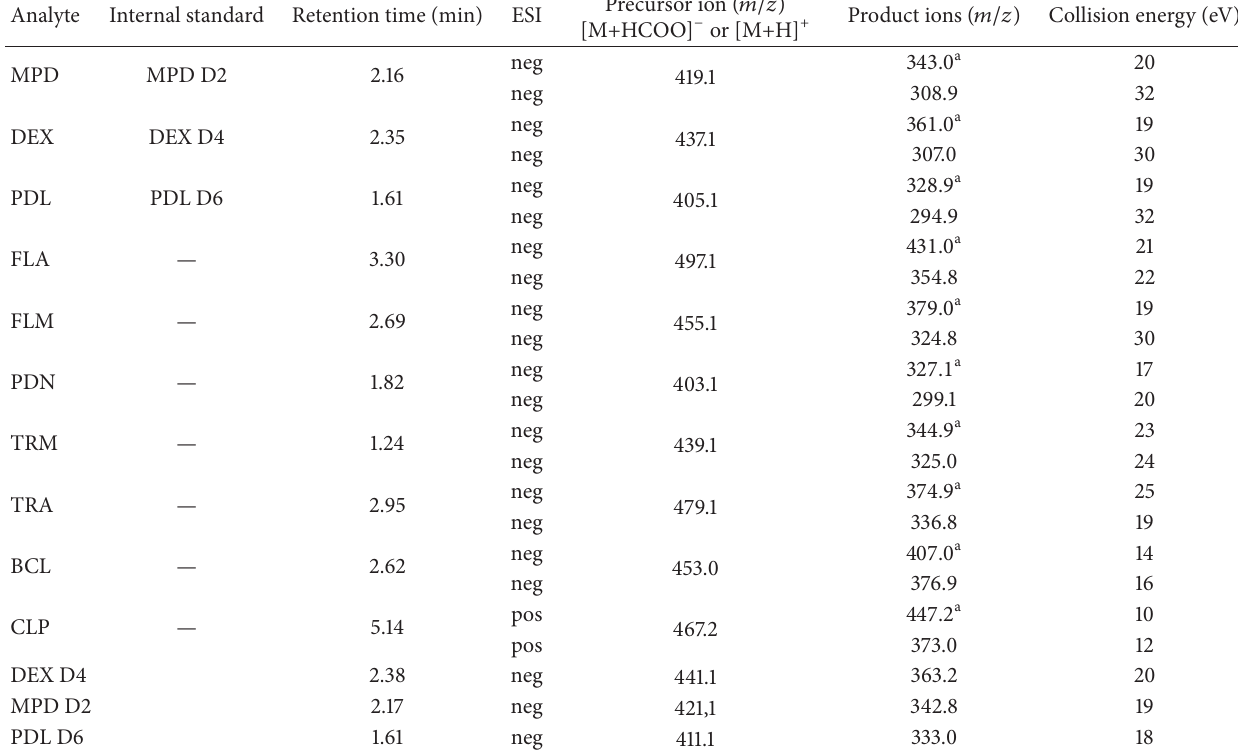
Table 1: Parameters for SRM acquisition of the corticosteroids. a The most abundant product ion. Analyte